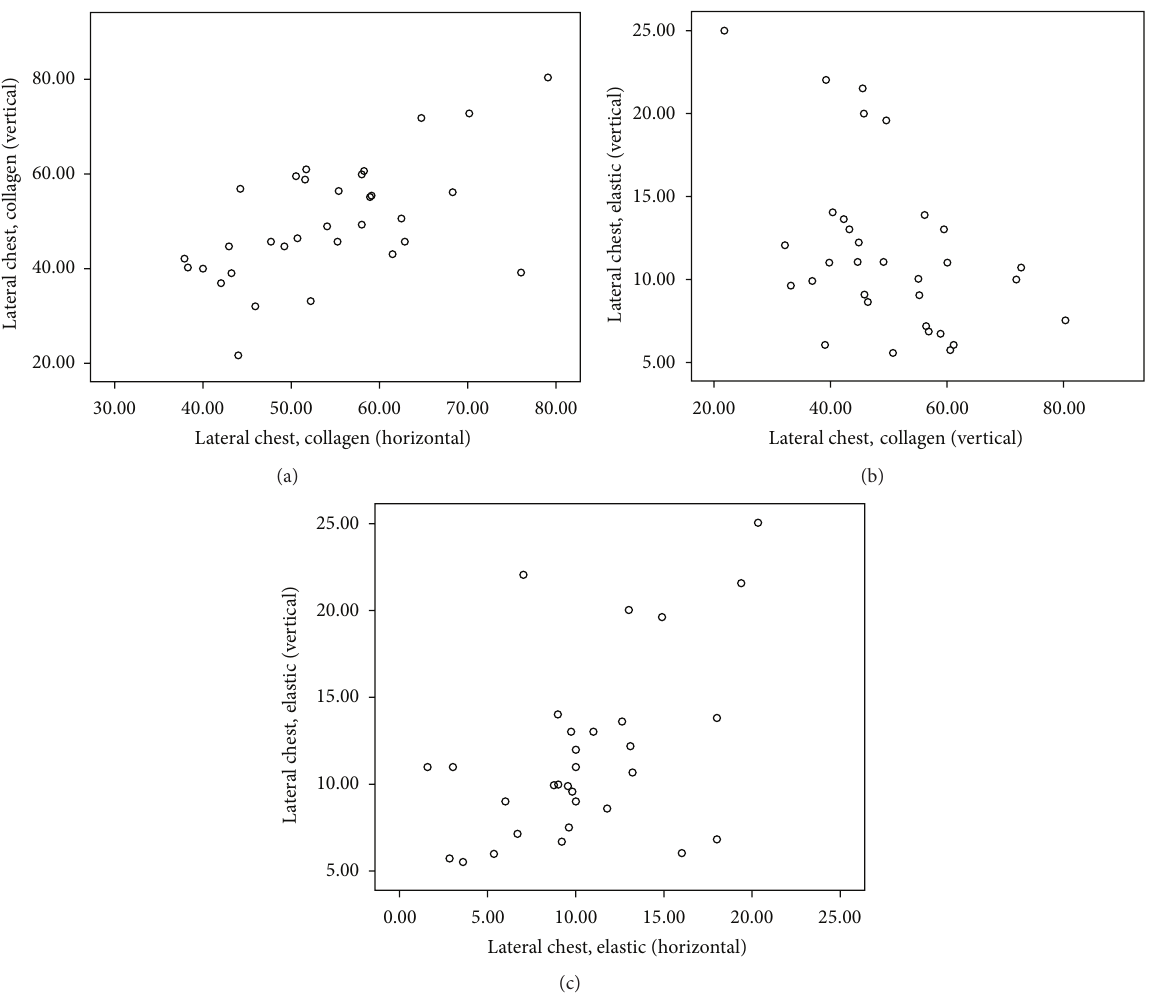
Figure 3: Scatter plot of significant Spearman correlation pattern at lateral chest area. (a) Moderate positive correlation between C H and C V . (b) Low negative correlation between C V and E V . (c) Low positive correlation between E H and E V (C H : collagen in horizontal, C V : collagen in vertical, E H : elastic in horizontal, and E V : elastic in vertical